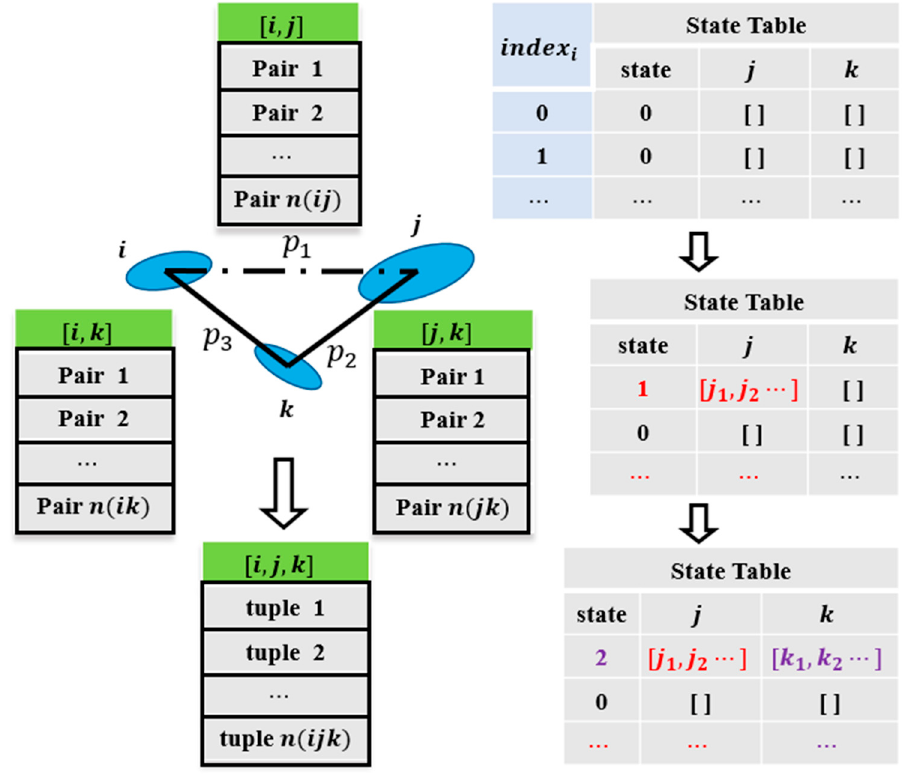
Figure 6. Search the base tuple of the pyramid using the state table.